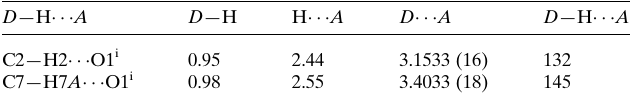
Table 3 Hydrogen-bond geometry (A˚ , (cid:2) ) for (IV).